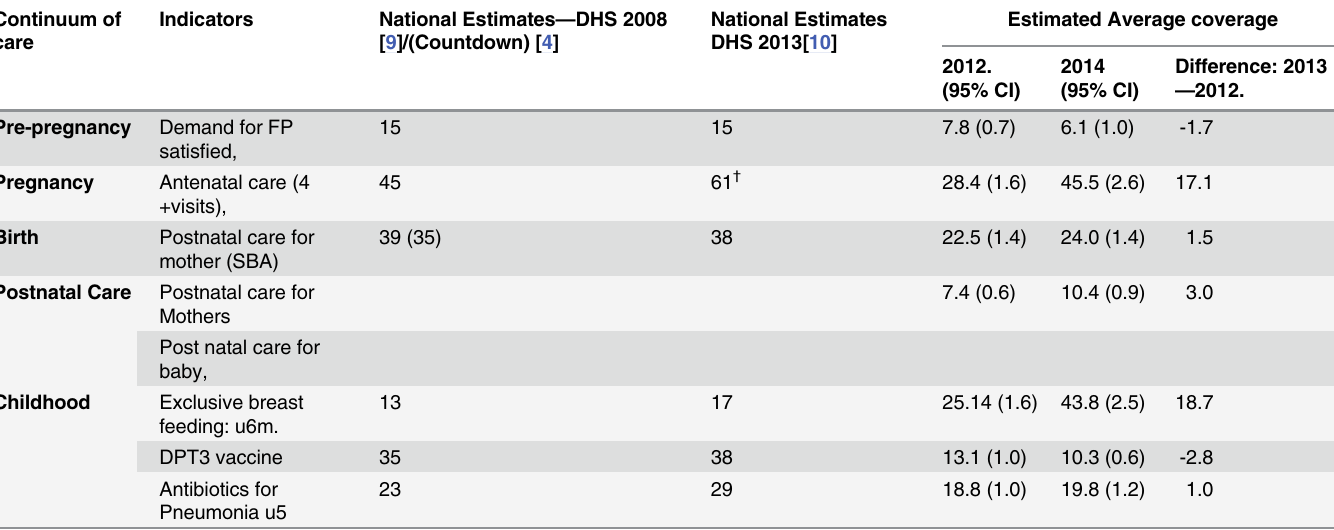
Table 1. National Averages and Coverage Estimates of the Indicators of the Continuum of Maternal and Child Health Care, 2012 and 2013. Continuum of